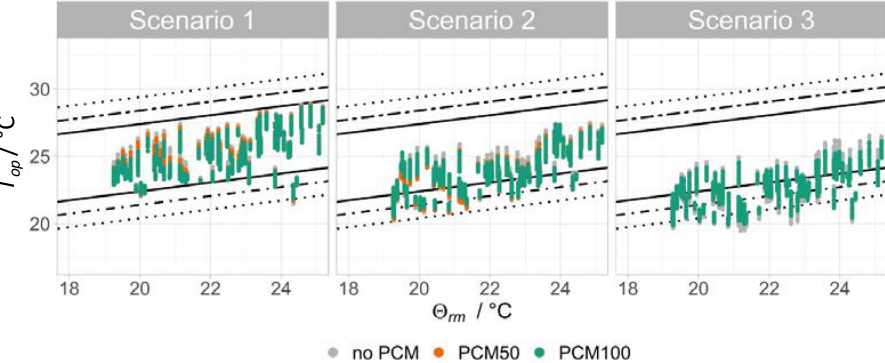
Figure 10. Comfort diagrams with simulated T op of the three different behavioural scenarios for office room. Black lines indicate different comfort categories: solid = Category I—high standard, dot-dashed = category II—middle standard, dotted = category III—moderate standard.